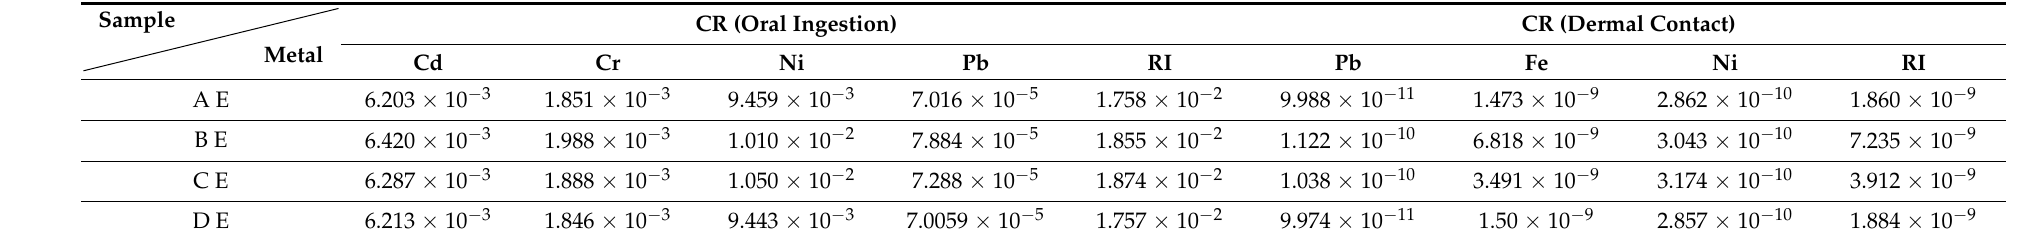
Table 3. Cancer risk (CR) and risk index (RI) for the selected heavy